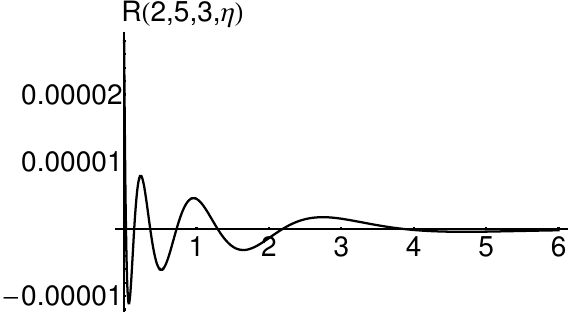
Figure 21: The residual R (2, 5, 3, η ) for Eq. (57) obtained by OAFM